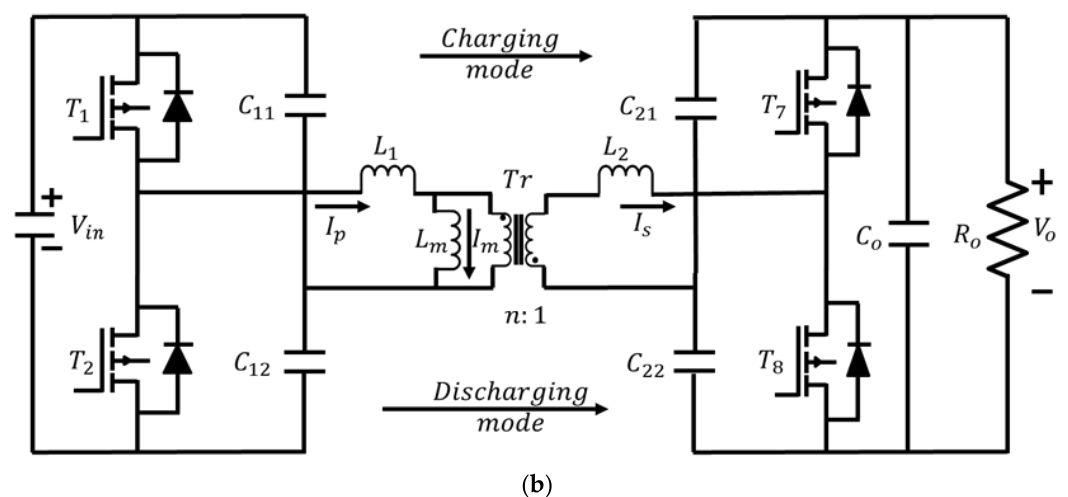
Figure 12. Bidirectional ( a ) FBCLLC and ( b ) HBCLLC resonant converter topology.